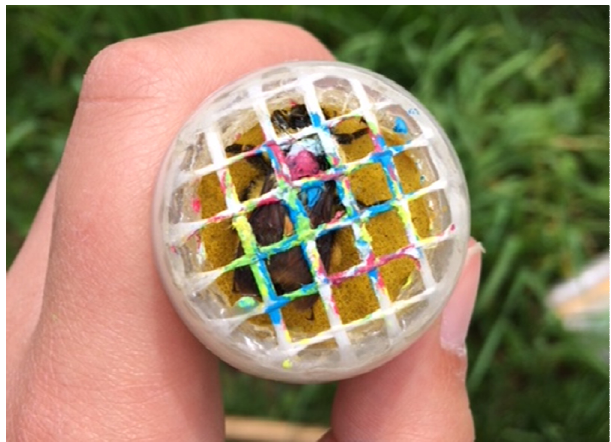
Figure 2. Bumble bee queen in a marking cage after being assigned a 3-color combination (i.e., white, red, and blue). Picture taken by A. Gervais.